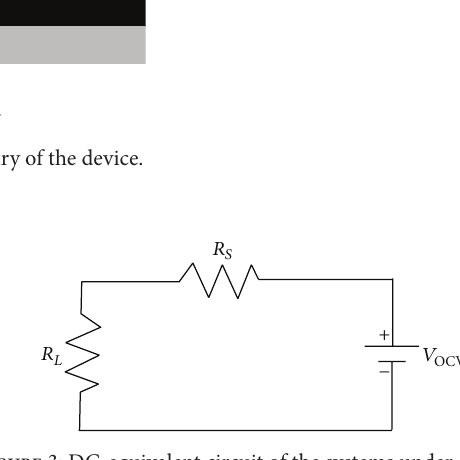
Figure 3: DC-equivalent circuit of the systems under